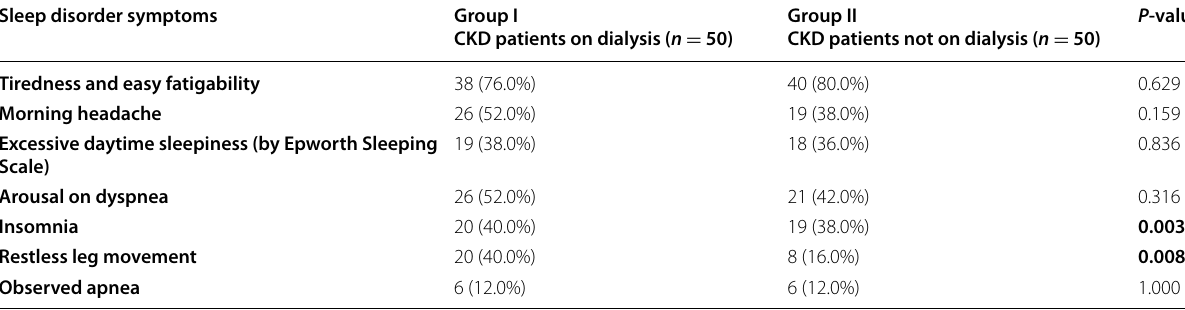
Table 2 Sleep disorder symptoms among both groups of CKD patients